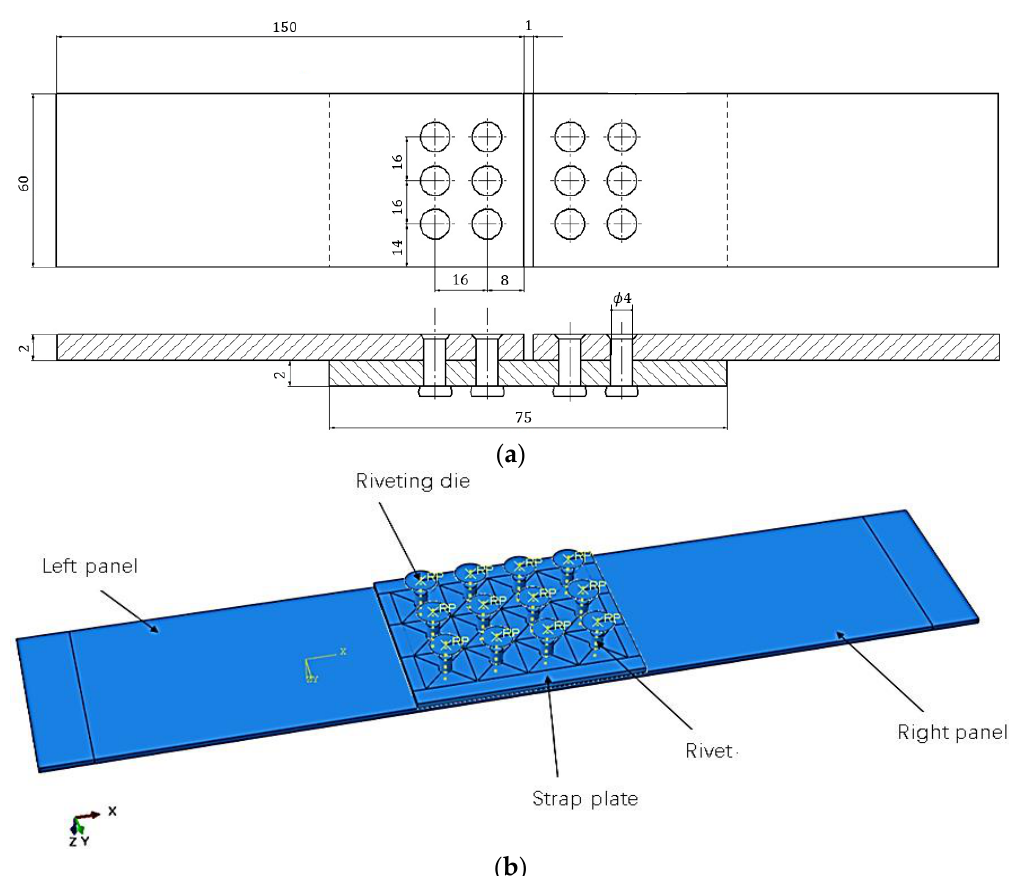
Figure 5. Schematic diagram of the structure of the strap butt joints: ( a ) schematic diagram of the composition and size of the strap butt joints(unit:mm); ( b ) schematic diagram of finite element model riveting assembly. Table 1. Material parameters of